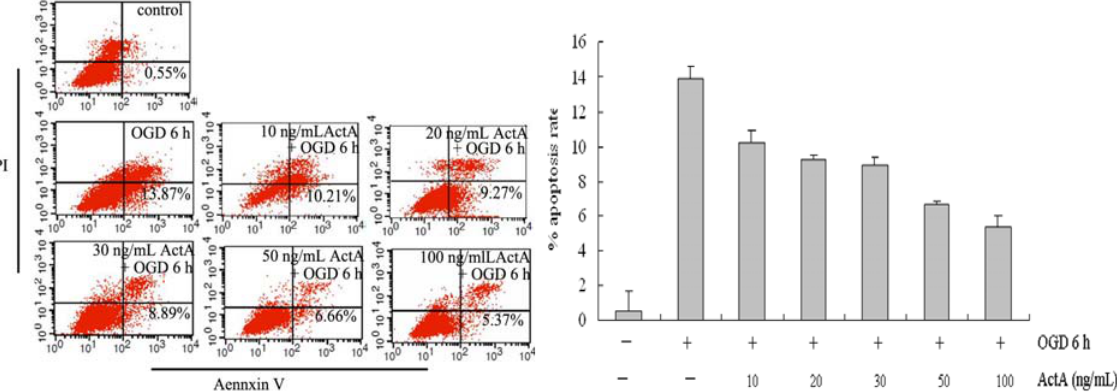
Figure 2. Flow cytometric analysis: assessment of apoptosis. OGD for 6 h treatment induced apoptosis in PC12 cells and ActA reduced cell damage. The cells were treated with OGD for 6 h or with different concentrations of ActA plus OGD for 6 h and were analyzed using flow cytometry following AnnexinV-FITC/PI staining. The data represent from three separate experiments that were performed in triplicate.